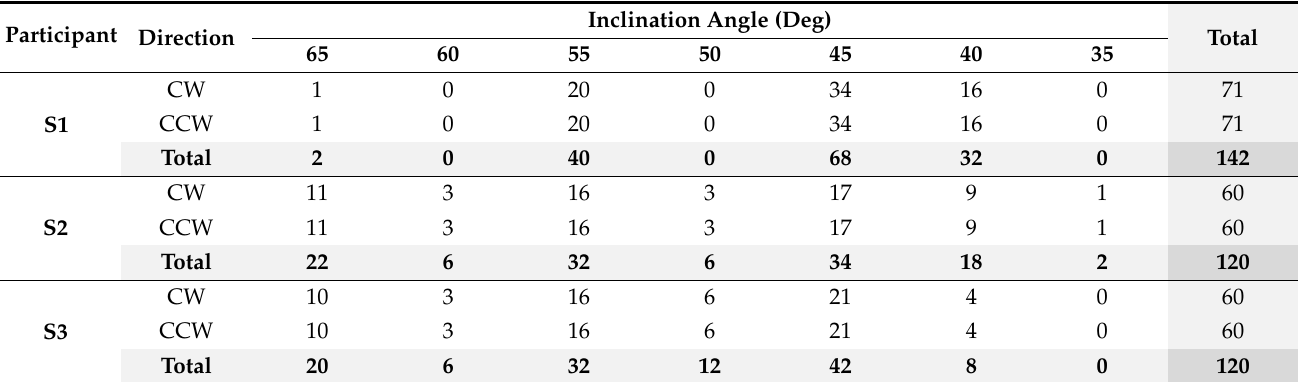
Table 2. AllCore360 rotations (spins) performed over 12 sessions of intervention. CW, clockwise; CCW,